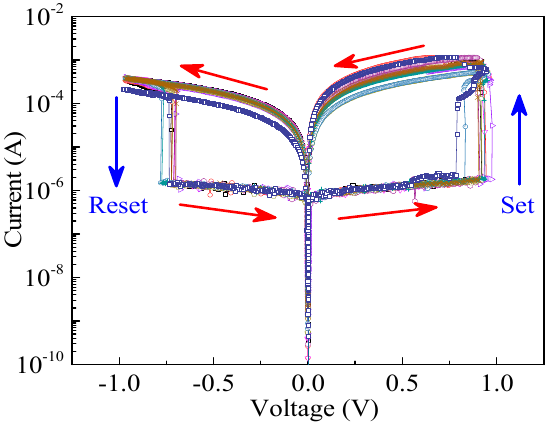
Figure 8. The repeated I – V characteristic curves under pulse voltage.